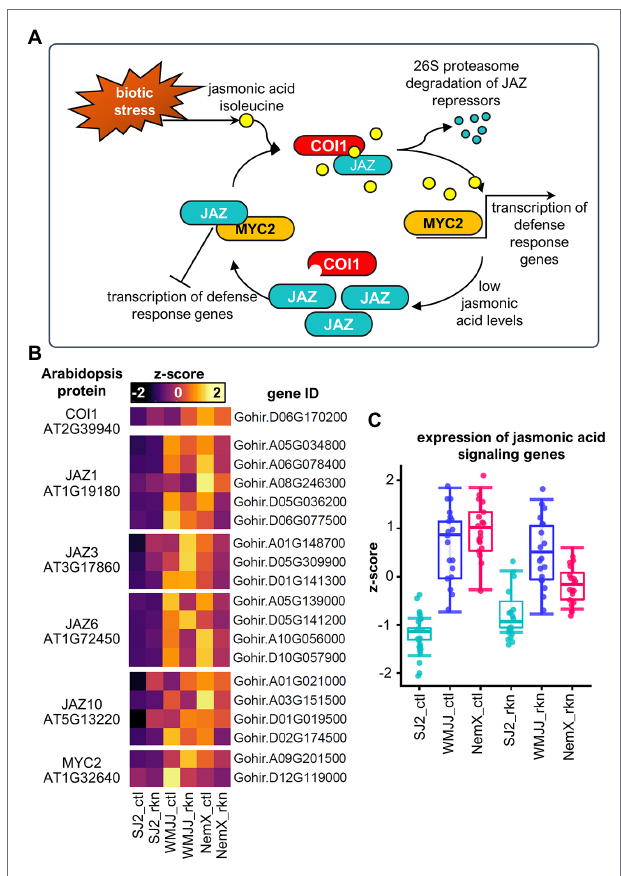
FIGURE 5 | Basal expression of jasmonic acid signaling is upregulated in NemX and WMJJ with respect to SJ2. (A) Jasmonic acid signaling in Arabidopsis. (B) Heatmap of the expression of Gh genes coding for orthologous proteins of Arabidopsis. (C) Boxplot analysis of the expression levels of jasmonic acid signaling genes presented in (B)